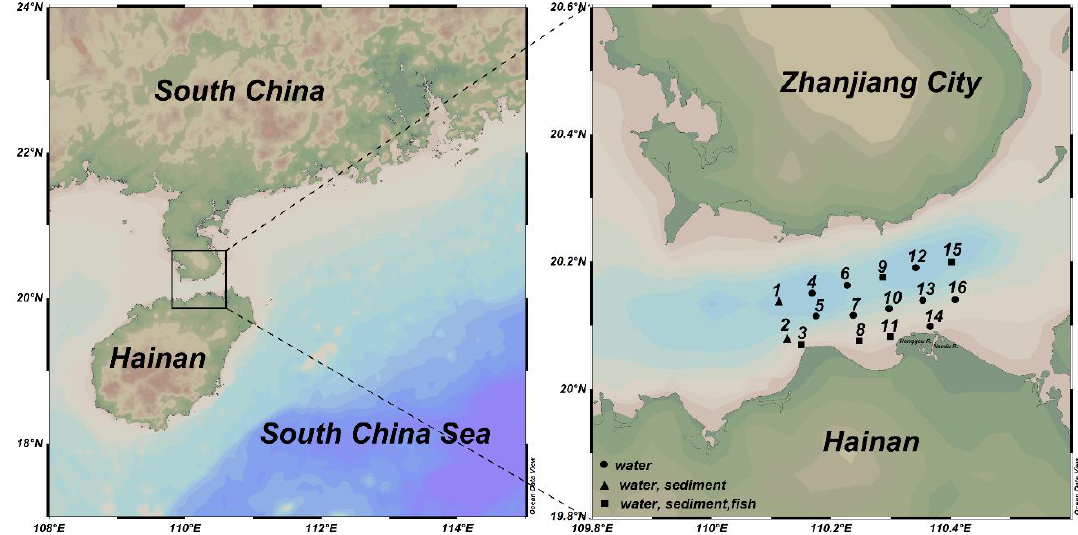
Figure 1. Schematic diagram of the study area and stations in Haikou Bay and adjacent seas.